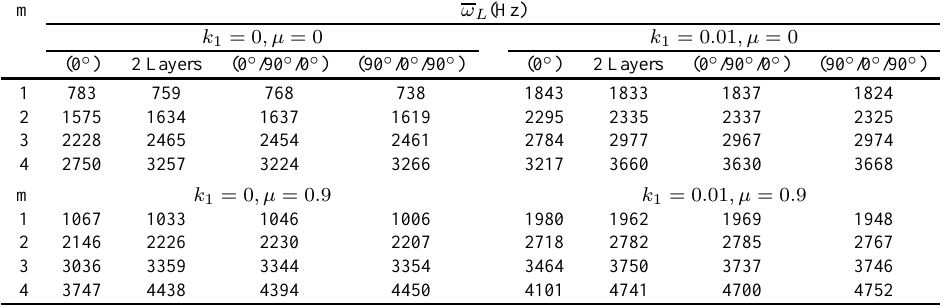
Variation of the natural frequency with respect to half axial wave number m , number and ordering of layers for k